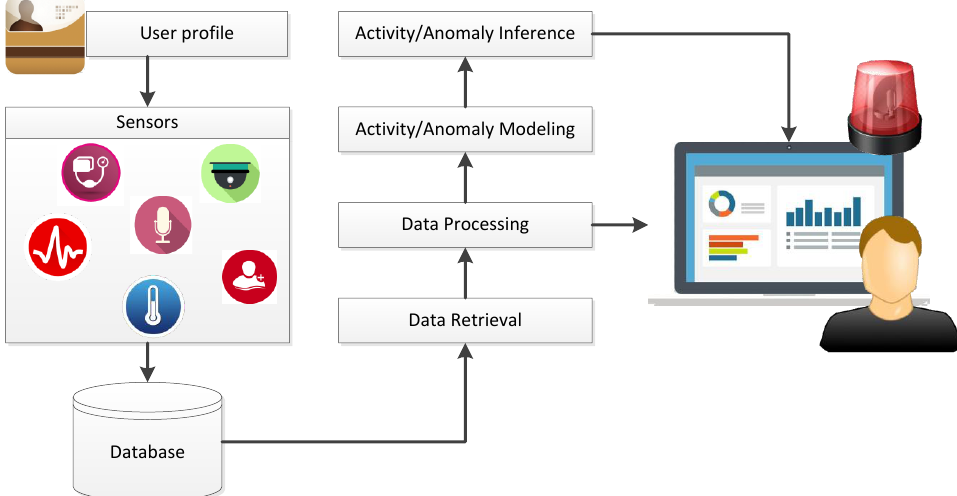
Figure 3. General architecture of an Ambient Assisted Living